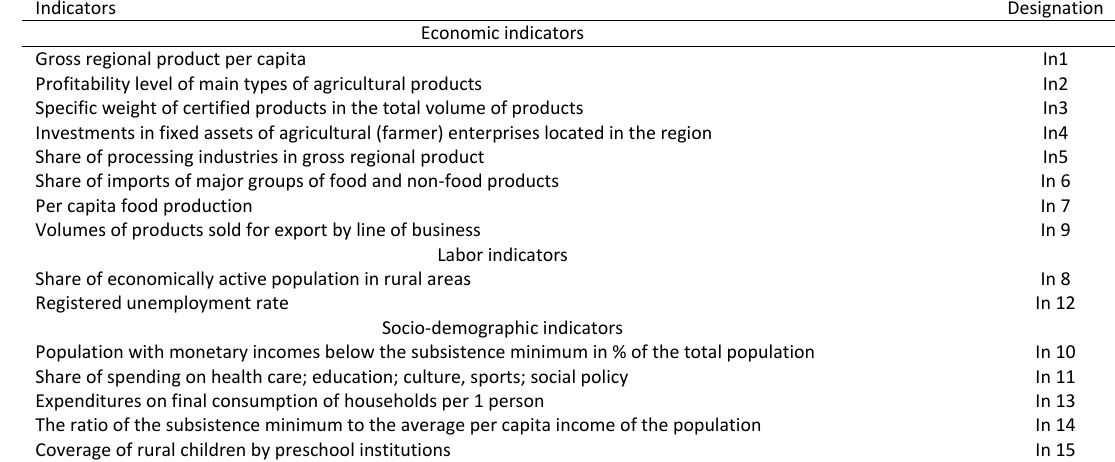
Table 2: System of indicators affecting the socio-economic development of rural areas Indicators